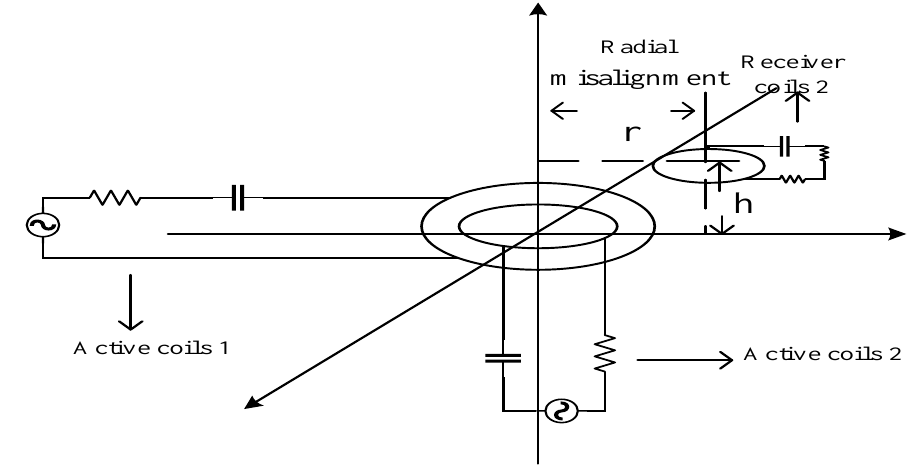
Figure 1. Proposed system for UAV charging.